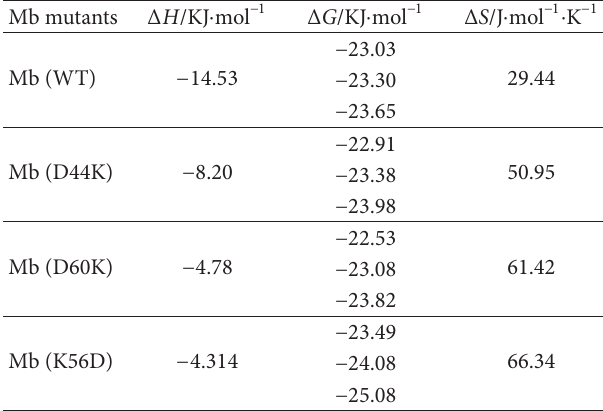
T 4: e thermodynamic parameters between Fe(III) and Mb mutants.